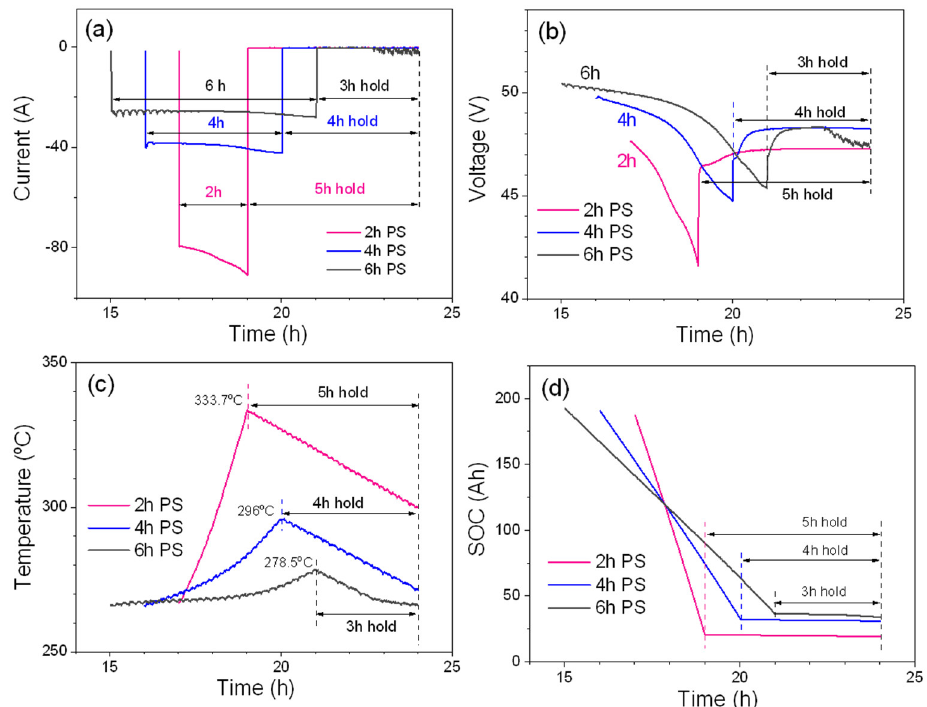
Figure 2. Peak-shaving test of 7.5 kWh discharge energy with the discharge time at 2, 4, and 6 h, respectively. ( a ) Current; ( b ) voltage; ( c ) temperature, and ( d ) SOC. An insert graph shown in ( d ) is a zoom-in view of SOC trends during the holding time.